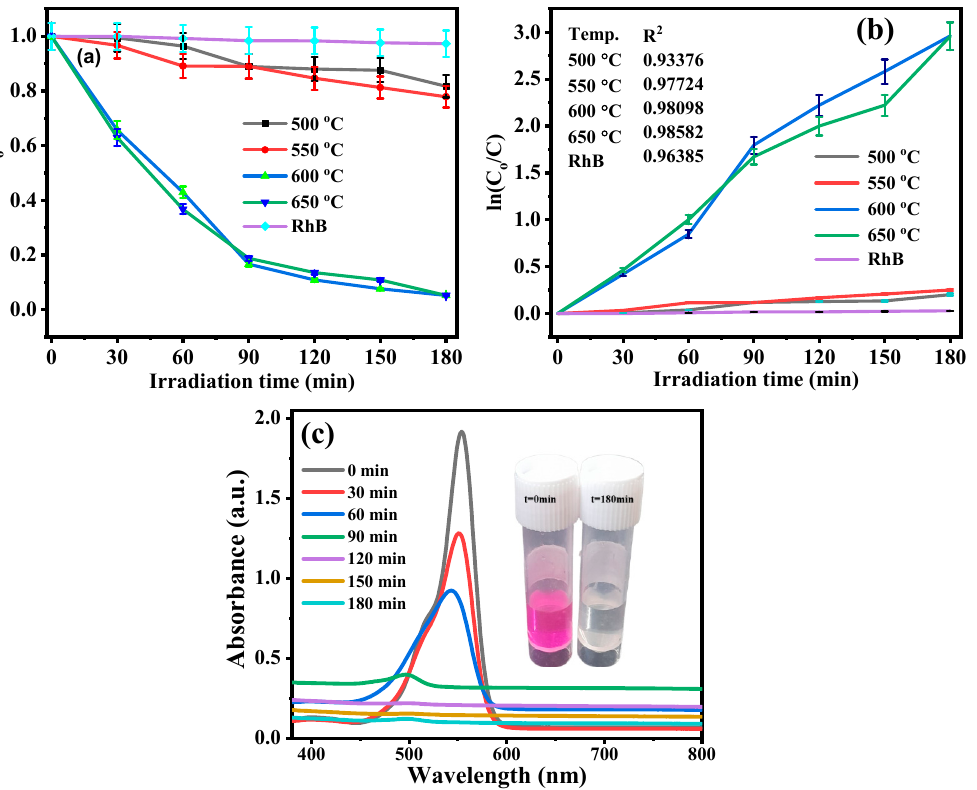
Figure 6. ( a ) Photoactivity of RhB of all prepared g-C 3 N 4 photocatalysts under visible-LED light irradiation ( b ) kinetics of RhB degradation as function of ln(C 0 /C) vs. irradiation time of all prepared g-C 3 N 4 photocatalysts and ( c ) UV-Vis spectra of RhB at different irradiation times over g-C 3 N 4 -600 °C (with inset image at t = 0 and t = 180 min) . Table 2. Photodegradation efficiency and reaction rate constant of all prepared g-C 3 N 4 samples at different calcination temperatures.